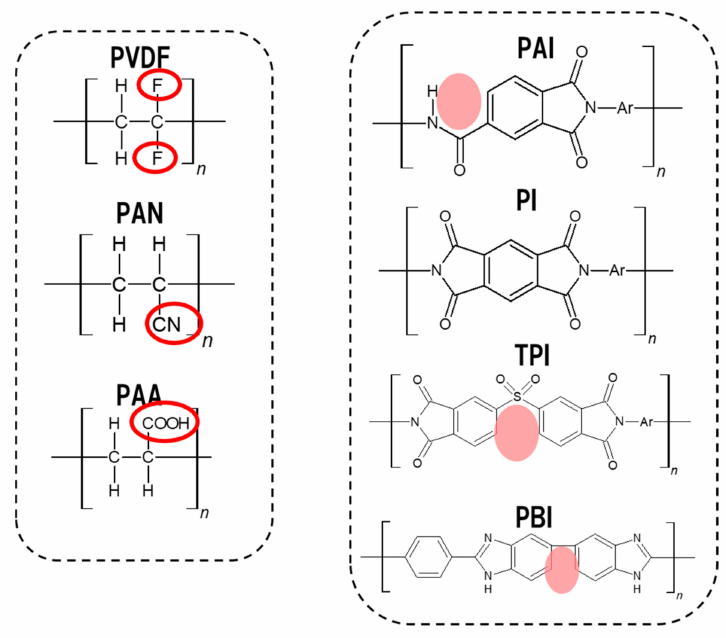
Figure 11. Schematic molecular skeleton